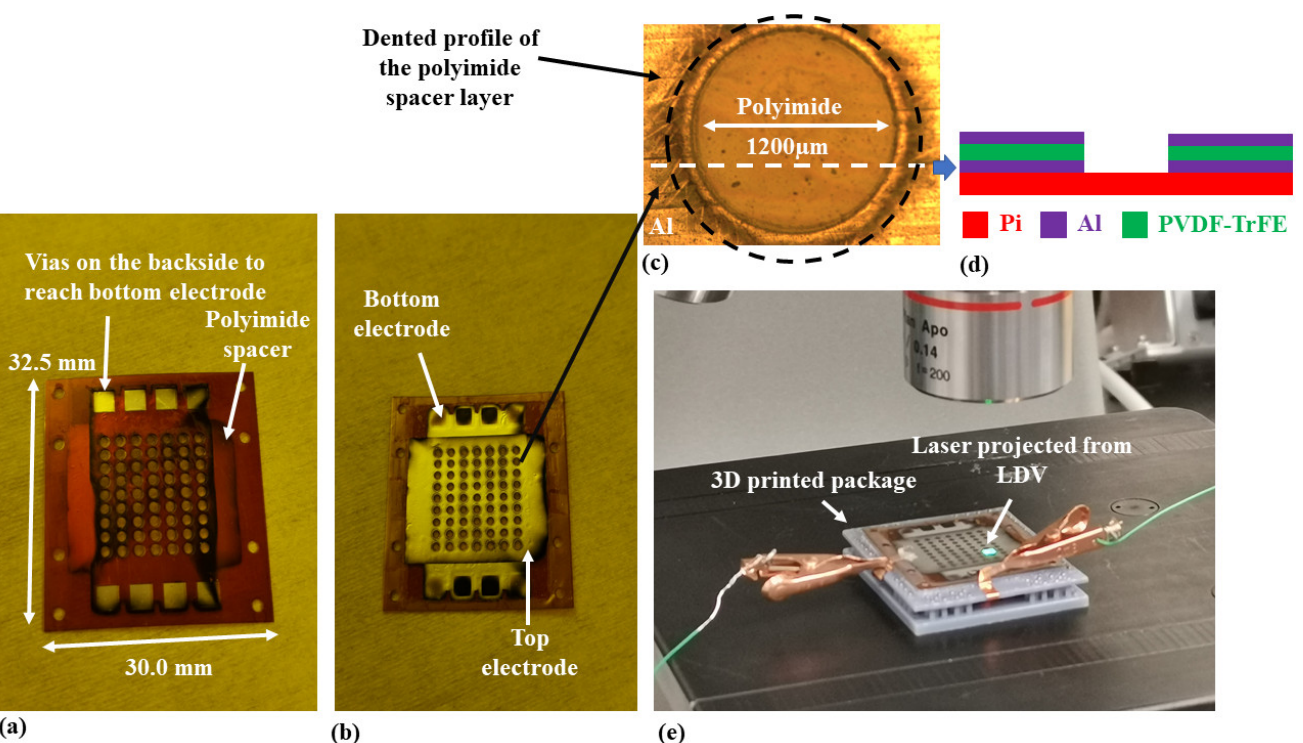
Figure 4. Optical images of fabricated MEMS test structures to evaluate the technology’s robustness. ( a ) The backside of the device, ( b ) The front side of the device, ( c ) Zoomed image of a single transducer, ( d ) Illustrated cross-section views of layers along the dashed line, and ( e ) Packaged MEMS transducer array during the measurement of electrically-driven mechanical resonance.